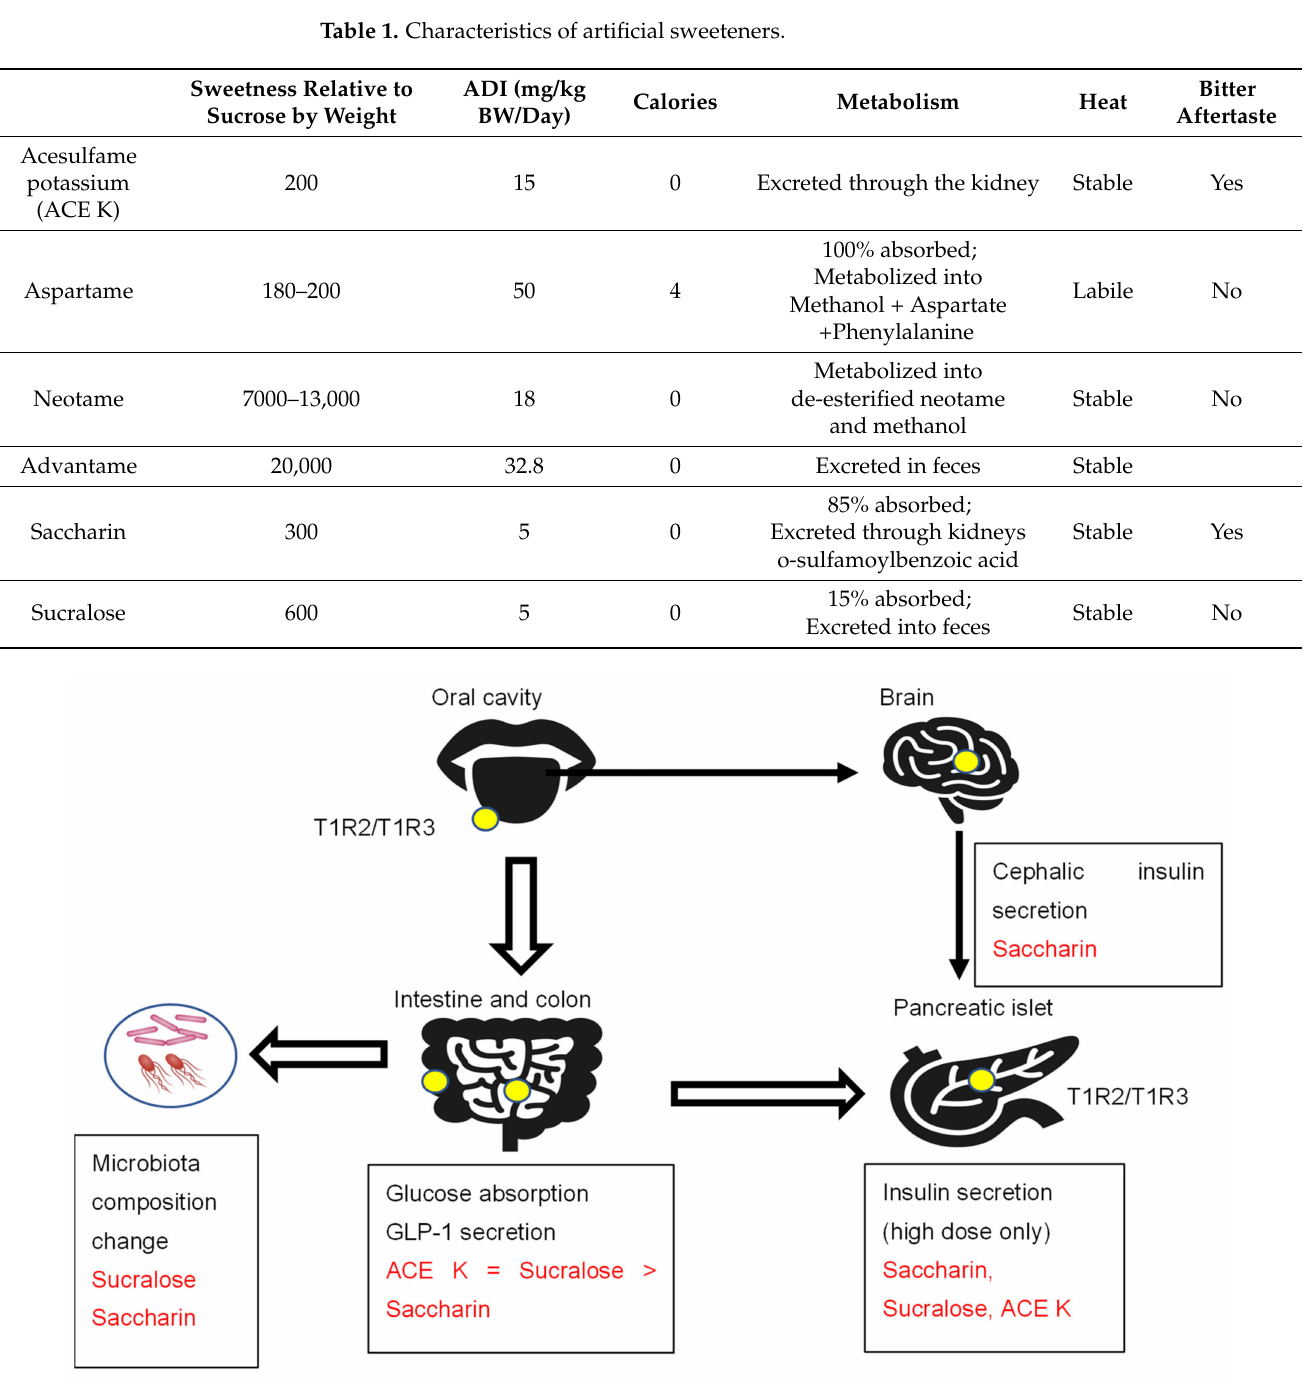
Figure 1. The sweet taste receptors T1R2/T1R3, artificial sweeteners, and metabolism. The sweet taste receptor complex T1R2/T1R3 is expressed in the oral cavity and extraoral tissues, such as the intestine, colon, pancreas, and brain. Artificial sweeteners activate sweet taste receptors and show several effects, such as insulin and incretin secretion and intestinal glucose